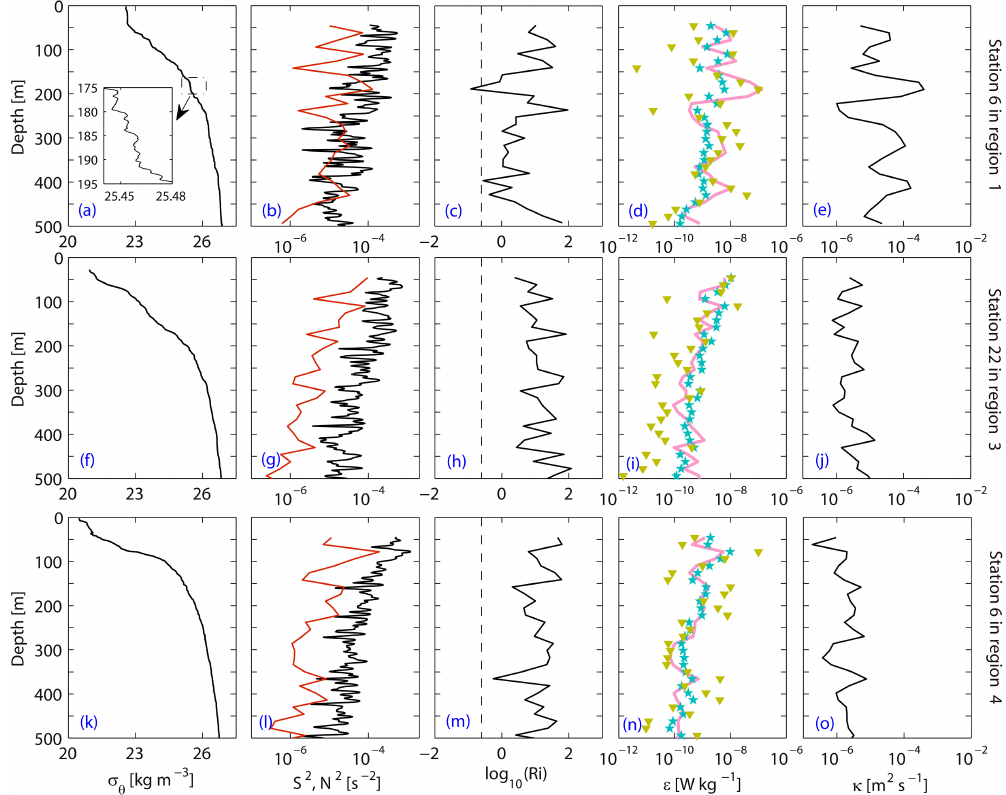
Figure 5. From top to bottom, three sets of profiles are from station 6 in region 1 (a, b, c, d, e) , station 22 in region 3 (f, g, h, i, j) , and station 6 in region 4 (k, l, m, n, o) . For each station, quantities plotted are (from left to right) potential density, shear variance (red) and buoyancy frequency squared (black), Richardson number (the vertical line indicates Ri = 0.25), observed (pink curves) and MG model (stars) and GH model (triangles) dissipation rates, and observed diapycnal diffusivity. The observed dissipation rate and diapycnal diffusivity have been vertically averaged over the 16m ADCP bins. The inset in (a) enlarges the density profile to show the